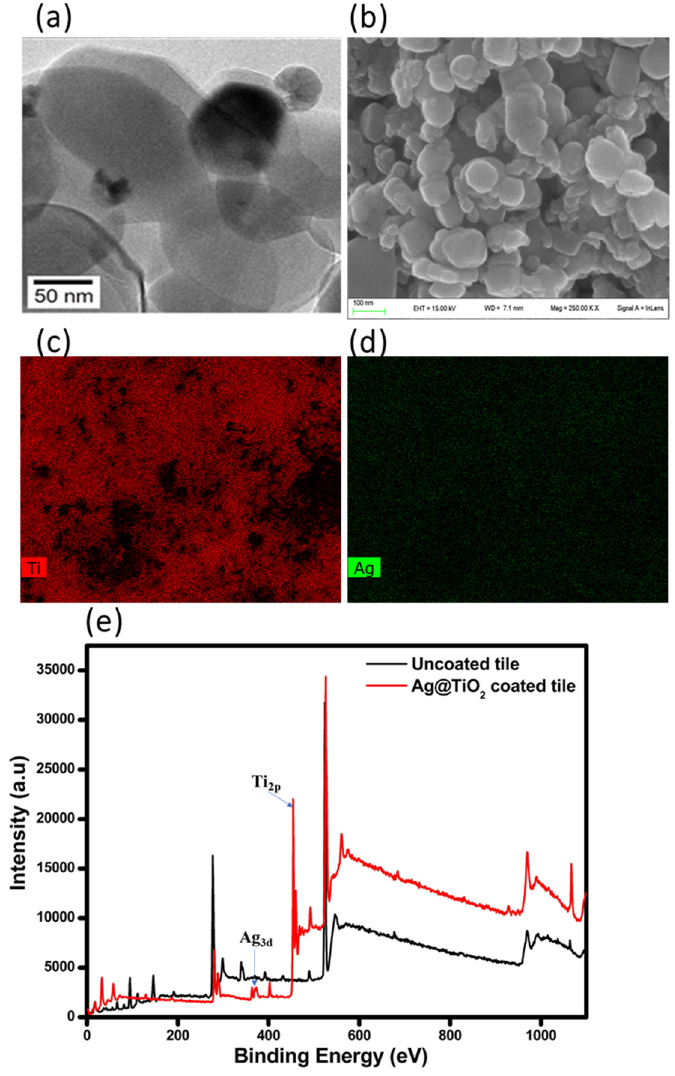
Figure 1. ( a ) HR-TEM images of Ag@TiO 2 powder. ( b ) SEM images of 8% Ag-decorated TiO 2 particles. ( c ) and ( d ) EDX mapping of Ti and Ag species, respectively, on the photocatalytic porcelain-grès tile. ( e ) XPS survey spectra of uncoated and Ag@TiO 2 coated tiles.